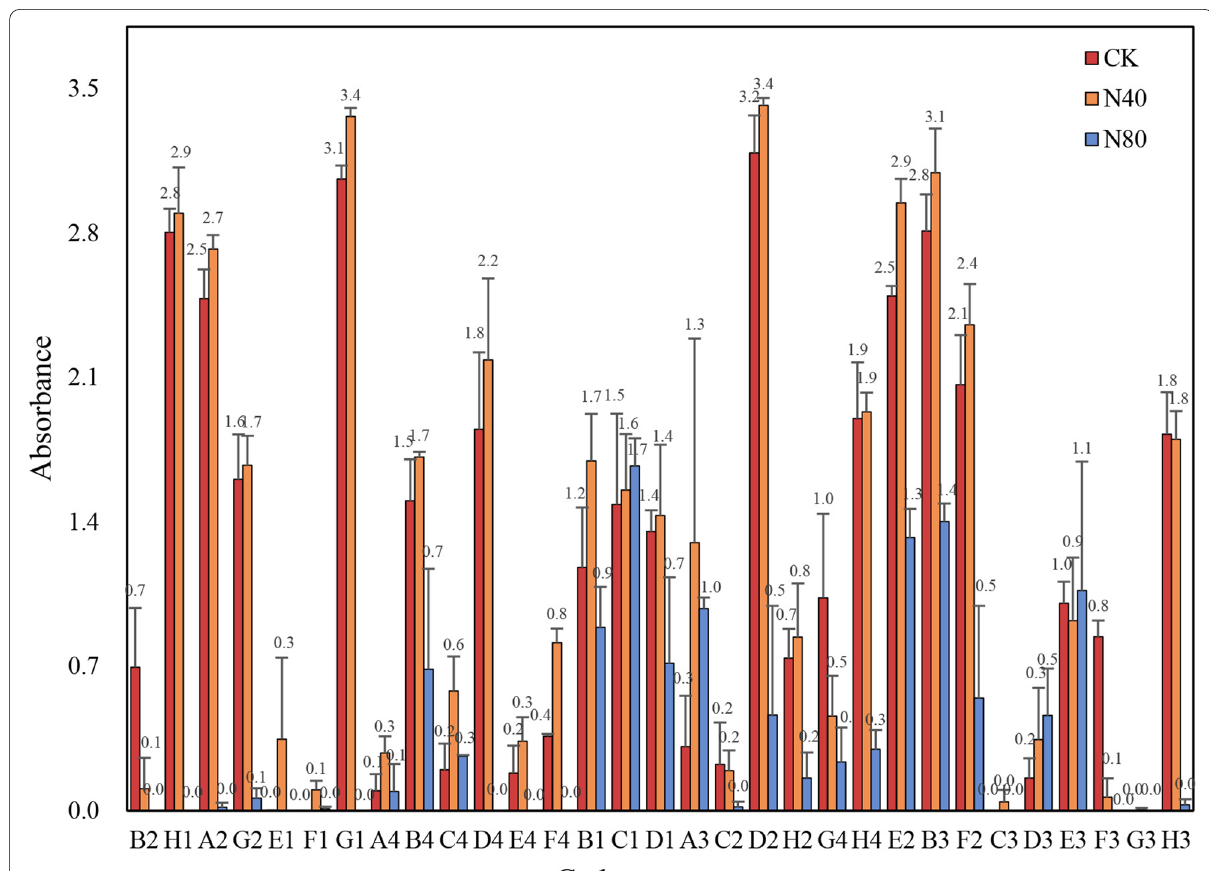
Fig. 3 Carbon physiological spectrum and metabolic fingerprint of soil microbial community in the Calamagrostis angustifolia wetland of the Sanjiang Plain. Carbohydrate, B2–D-xylose, H1– α -D-lactose, A2– β- methyl-D-glucoside, G2– α -D-glucose-1-phosphate, E1– α -cyclodextrin, F1– glycogen, G1–D-cellobiose; amino acids, A4–L-arginine, B4–L-asparagine, C4–L-phenylalanine, D4–L-serine, E4–L-threonine,